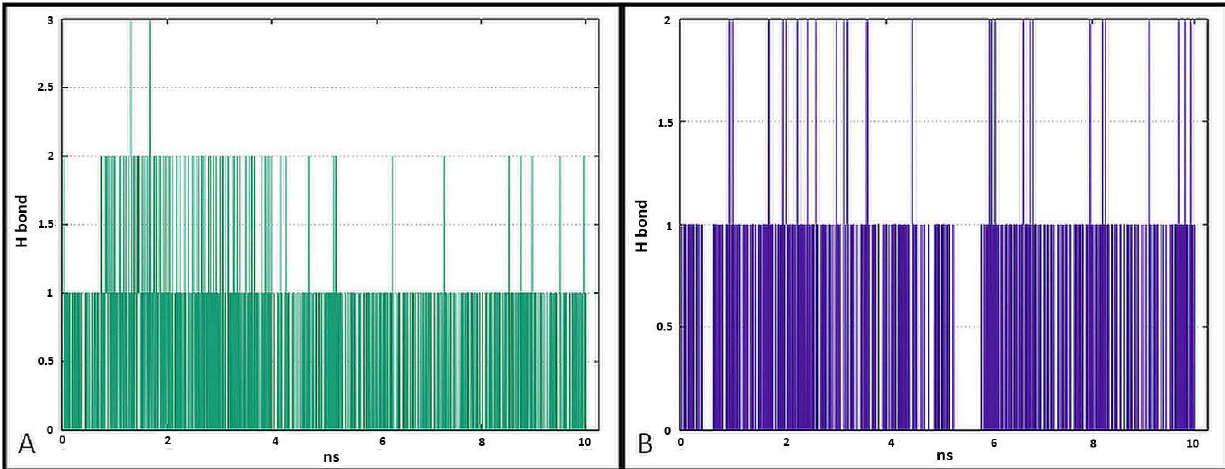
Figure 17. Pictorial representation of the number of H-bond contacts formed by ligand 7a ( A ) and 7b ( B ) with EGFR tyrosine